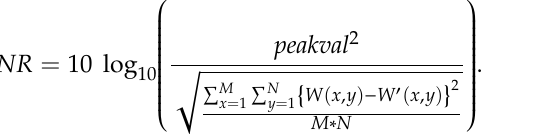
Figure 7. ( a ) Image after segmentation, ( b ) Watermark image and ( c ) Watermarked